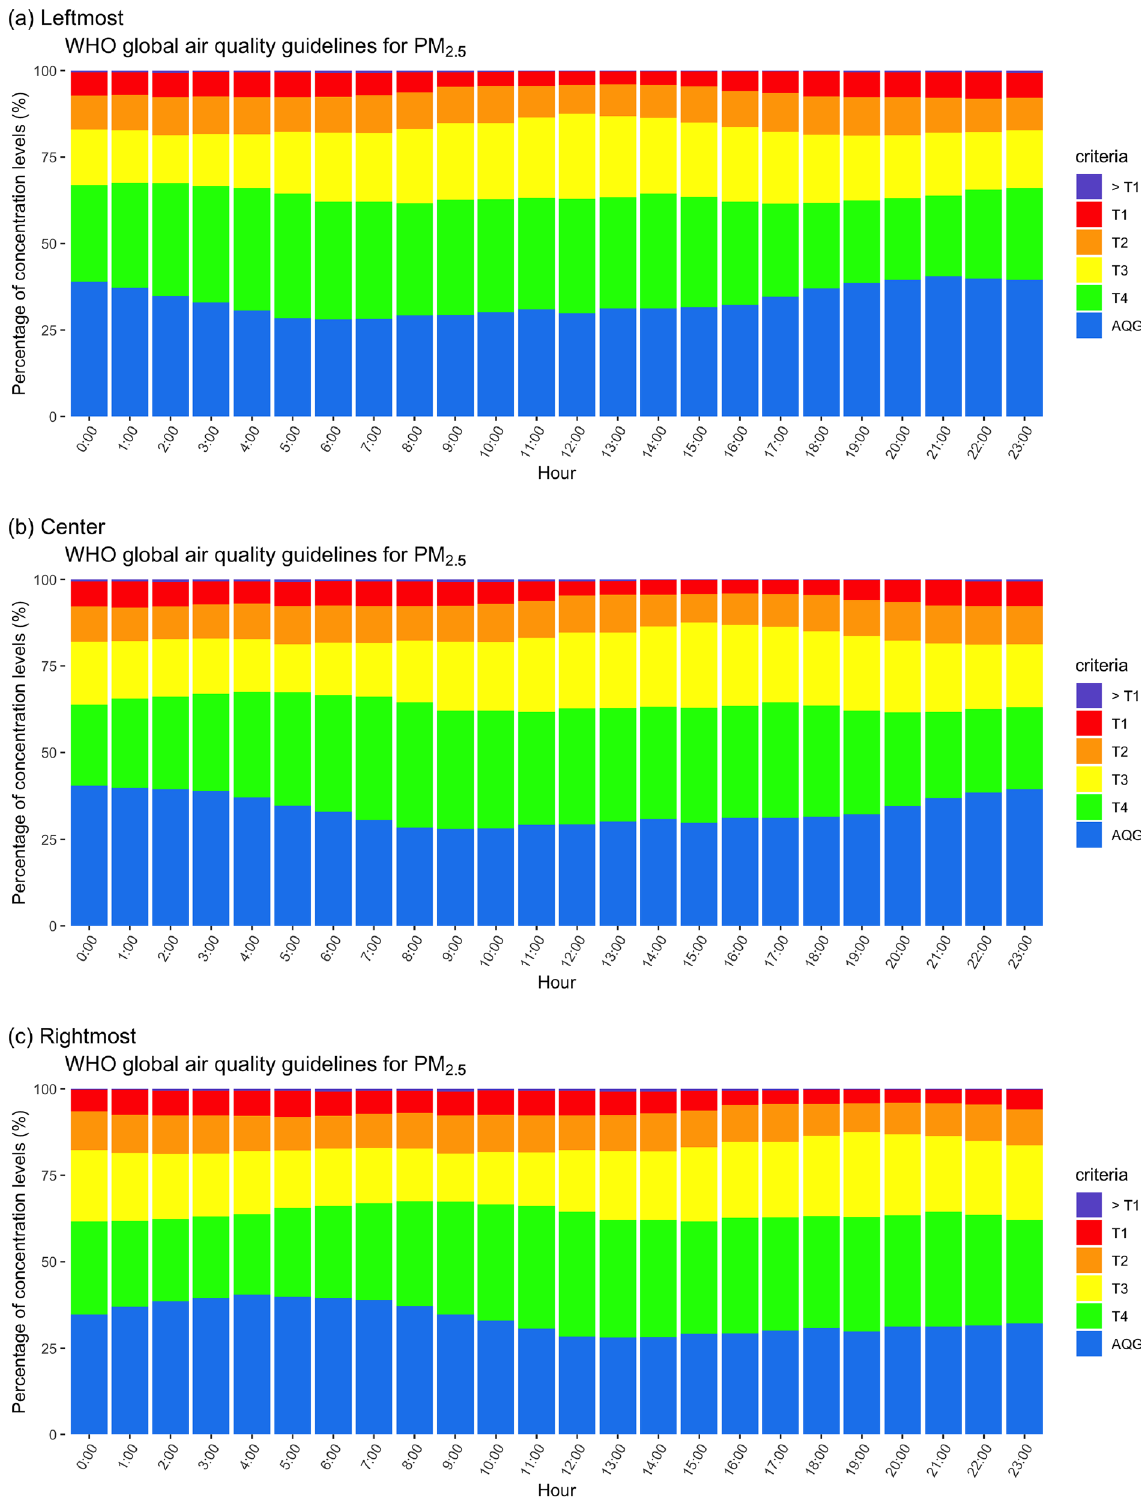
Fig. 6 Time variation of PM 2.5 concentration measured against WHO guideline at station 02